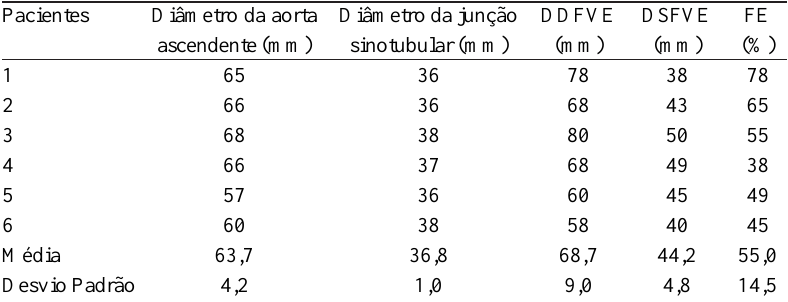
Tabela 2. Ecocardiograma